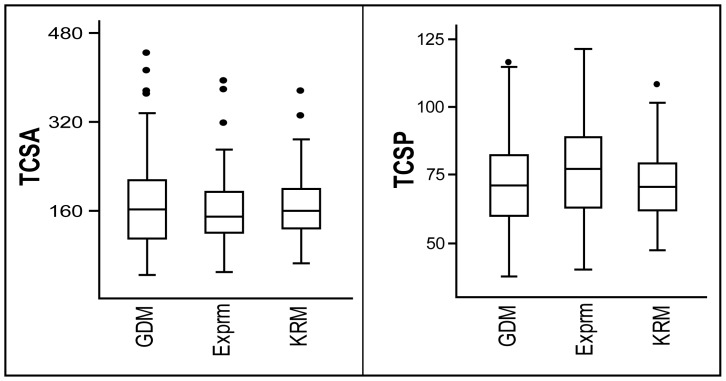
Box-and-Whisker plots of TCSA and TCSP comparisons.TCSA and TCSP plots of pointed pieces from experimental spear tips [25] (Exprm); Klasies River main site MSA I [32] (KRM); Gademotta (GDM). Solid dots represent outlier values.